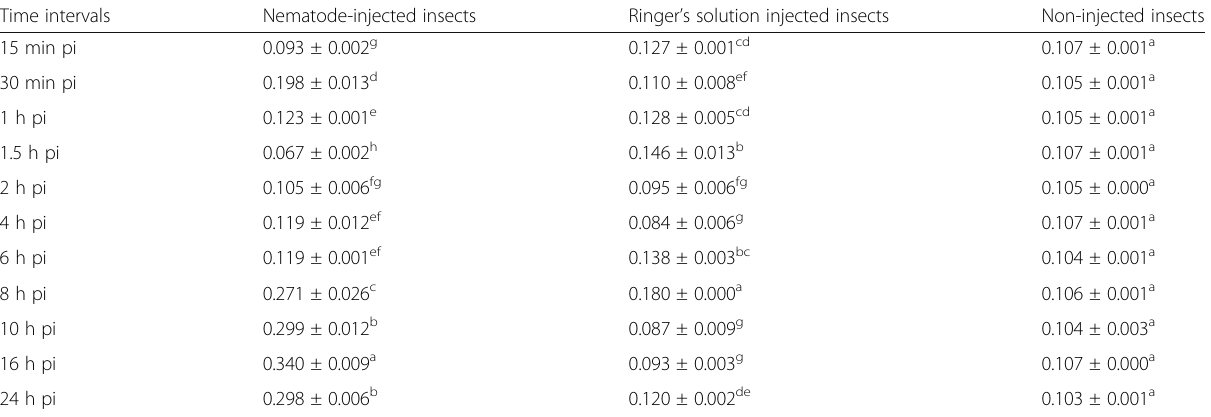
Table 2 Phenoloxidase units of injected nematode, Ringer ’ s solution as compared to those of non-injected insects at different time intervals Time intervals Nematode-injected insects Ringer ’ s solution injected